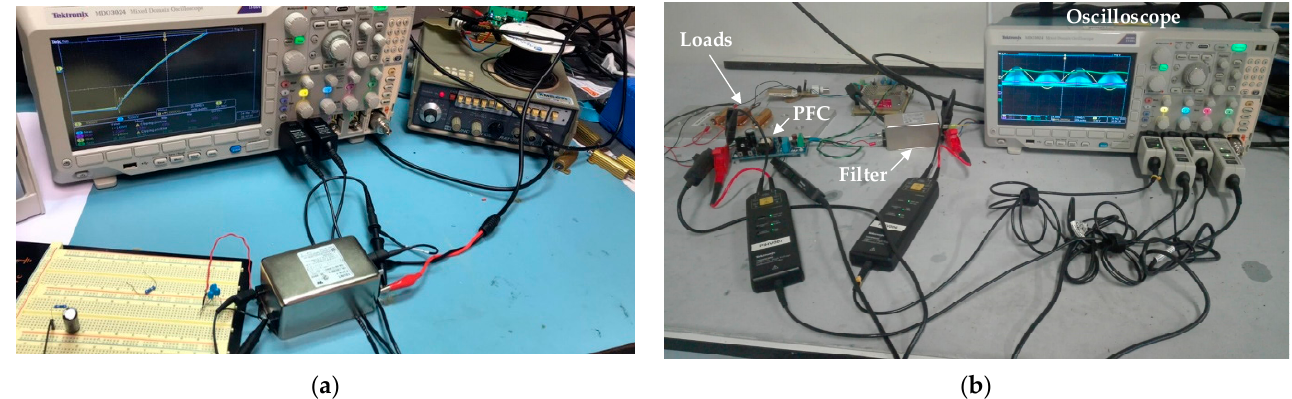
Figure 10. Experimental setup meant for the: ( a ) Corcom 10VN1 EMI filter parameter estimation; ( b ) STMicroelectronics STEVAL-ISA102V2 AC-DC boost PFC converter connected to the EMI filter.